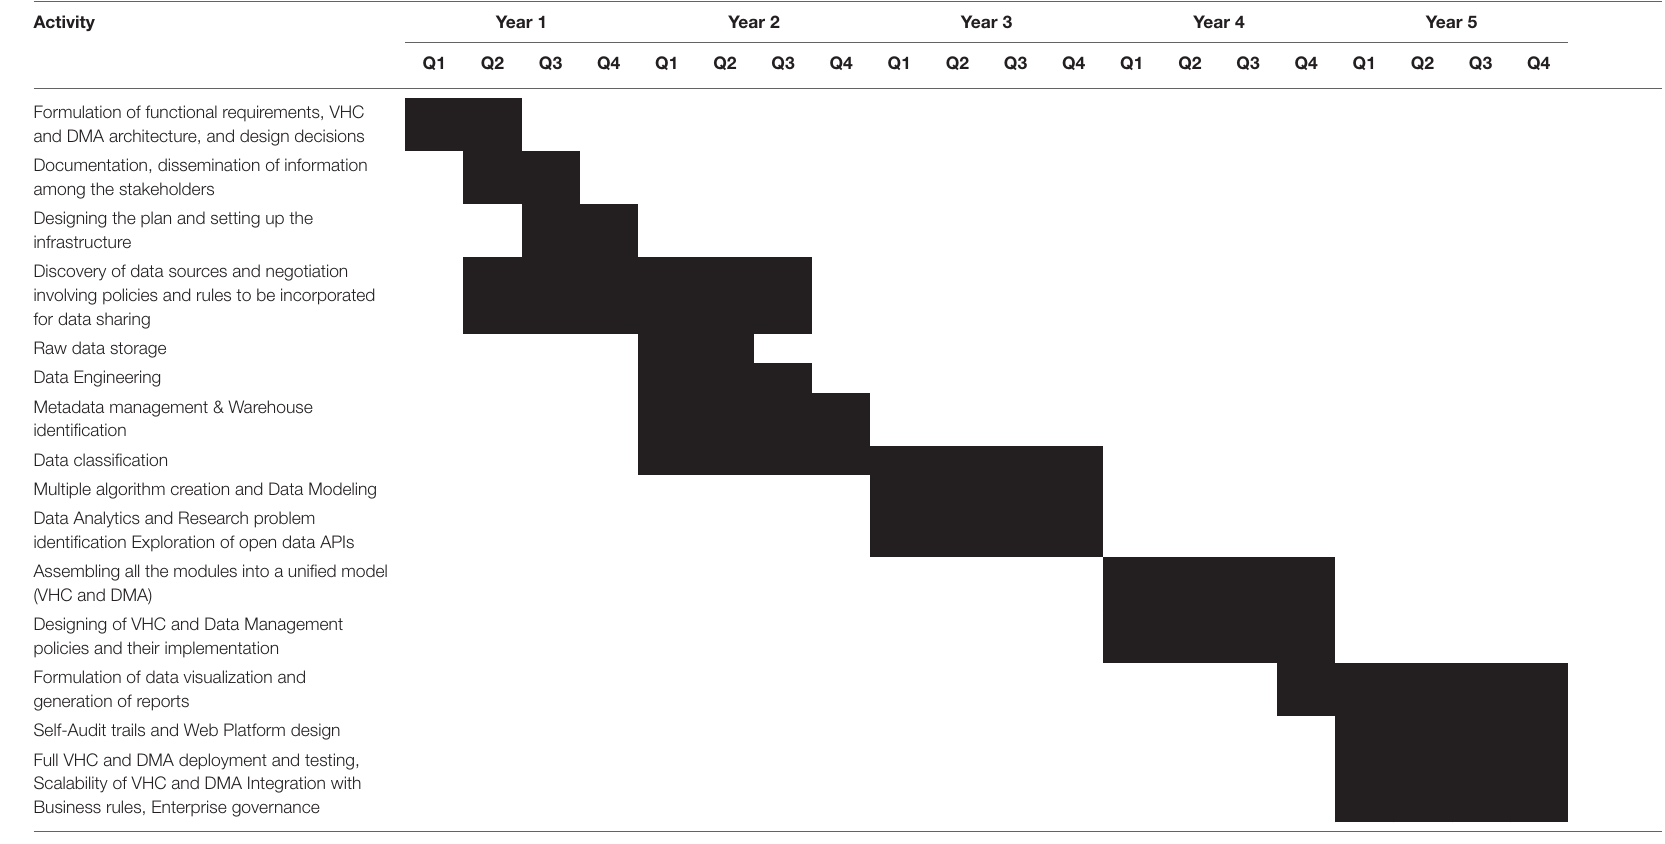
TABLE 1 | Plan of action and research